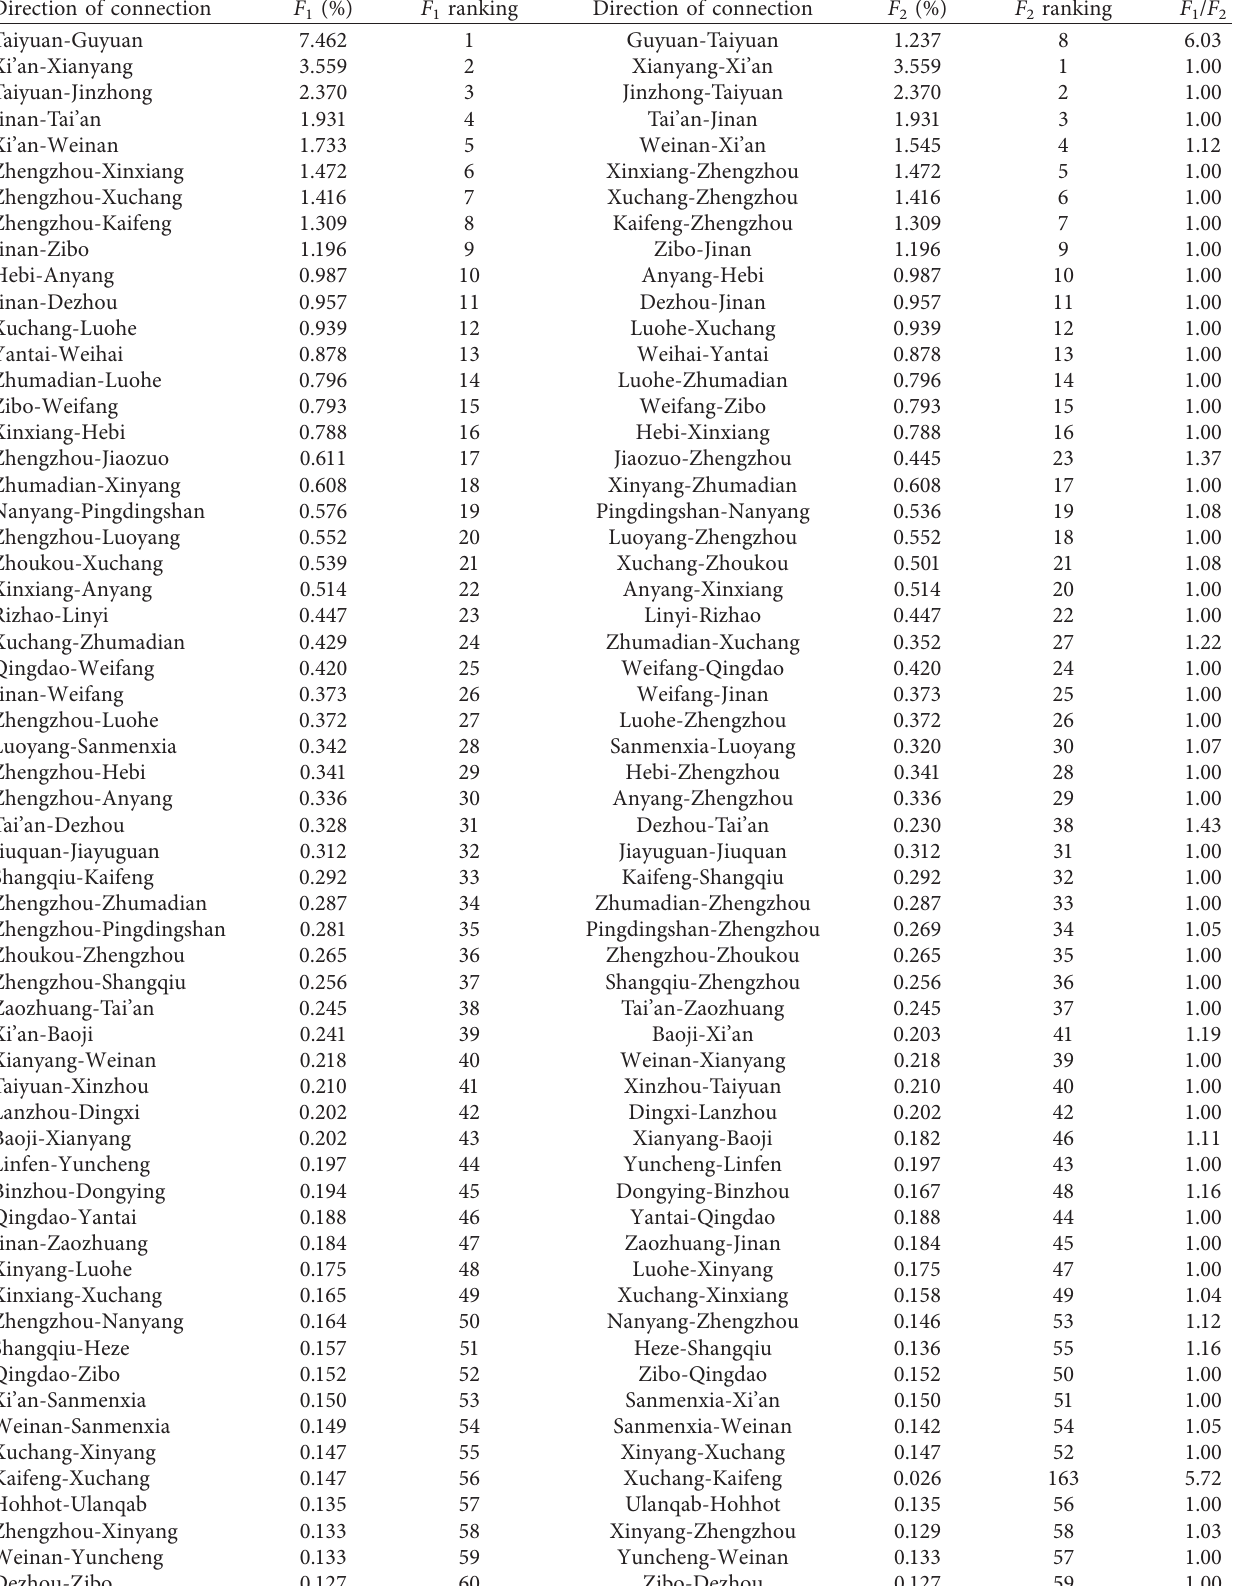
Table 3: Top 60 (ranked by F 1 ) of intercity connection intensity in the Yellow River basin. Direction of